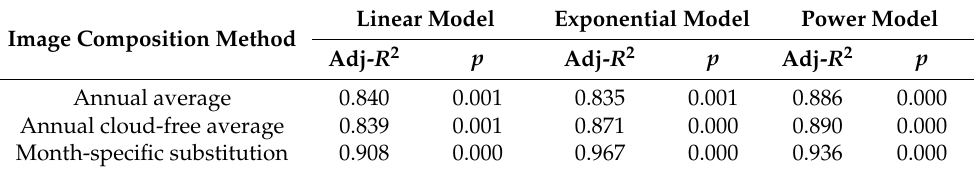
Table 8. Results of the regression models of total night-light data vs. electricity consumption. Image Composition Method